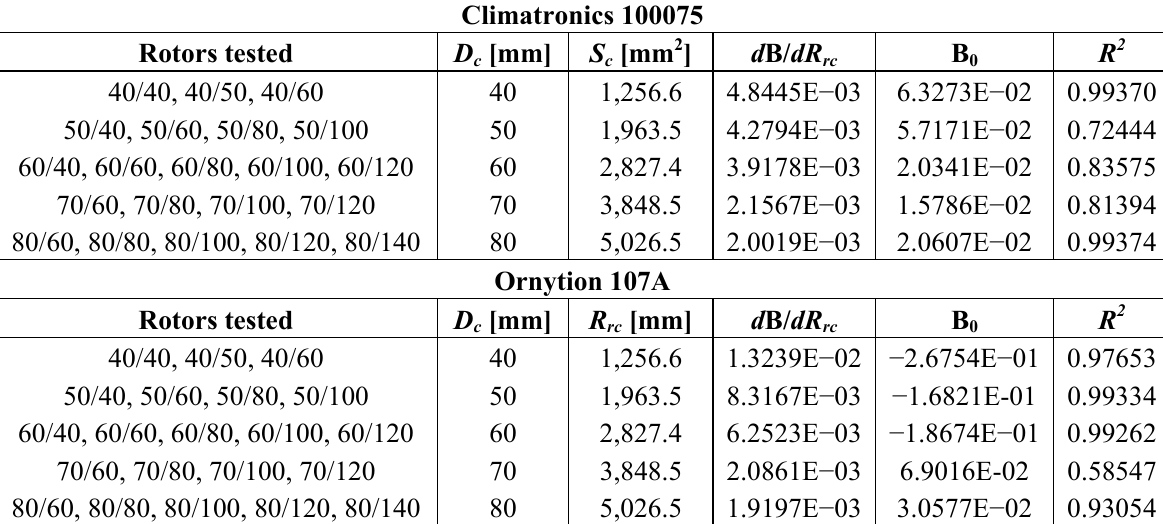
Table 3. Linear fittings (slope, d B/ dR calibration constants B as a function of the cups center rotation radius, R calibrations performed on Climatronics 100075 and Ornytion 107A anemometers, equipped with the same rotors. The diameter, D also